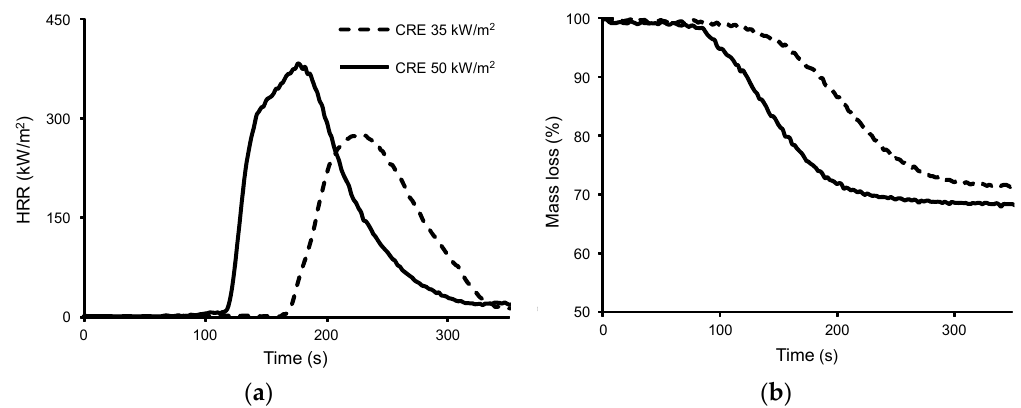
Figure 3. ( a ) Heat release rate (HRR) and ( b ) mass loss versus time curves of the control CRE at 35 and 50 kW/m 2 heat fluxes.